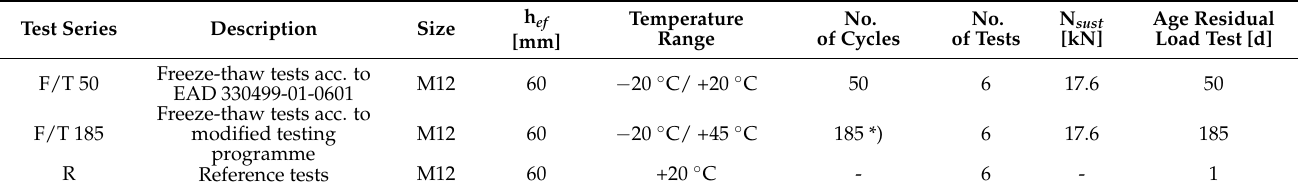
Table 1. Overview of the performed test programme under freeze-thaw conditions.